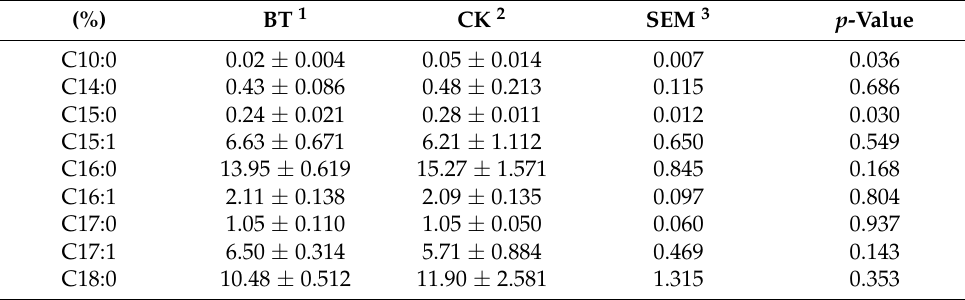
Table 3. The contents of individual fatty acids and calculated fatty